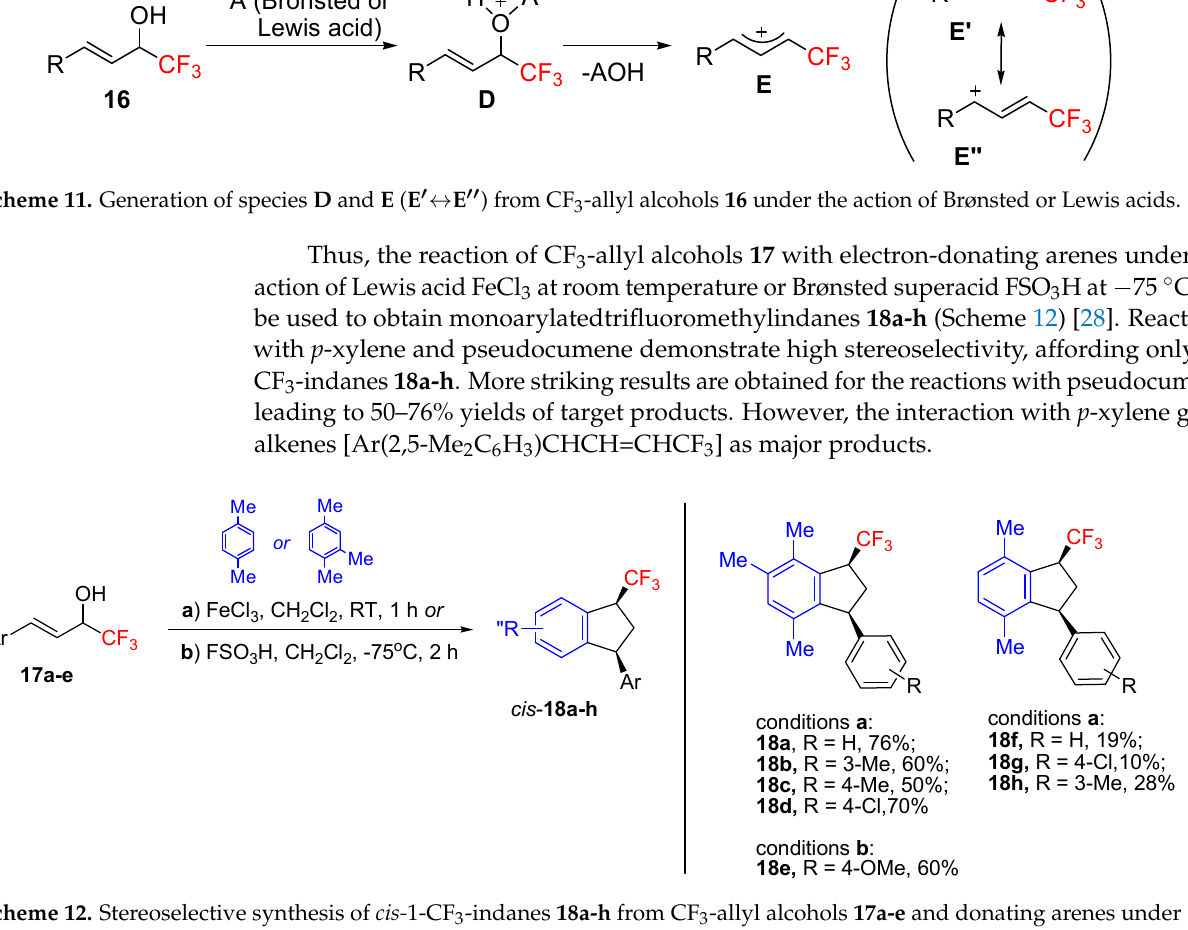
Scheme 12. Stereoselective synthesis of cis- 1-CF 3 -indanes 18a-h from CF 3 -allyl alcohols 17a-e and donating arenes under the action of Lewis acid FeCl 3 or Brønstedsuperacid FSO 3 H.